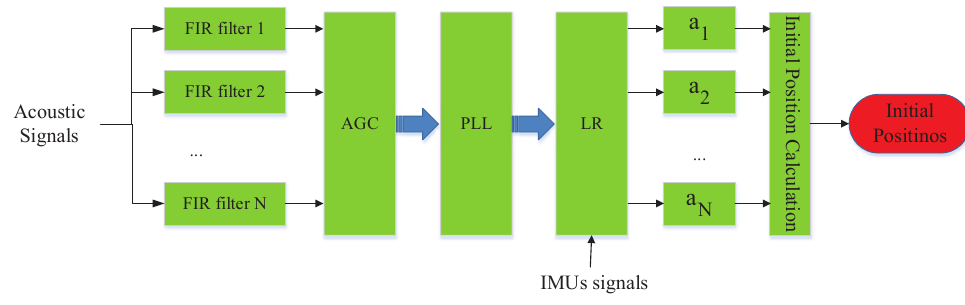
Figure 6. Procedure of Acoustic Localization . Acoustic signals firstly pass through FIR filter and AGC to eliminate interference. Then, PLL tracks the changes of the phase of received acoustic signals. The 2D relative directions ( α 1 , α 2 , . . . , α N ) are calculated via LR algorithm. Finally, Initial Position Calculation computes coordinate using relative directions.